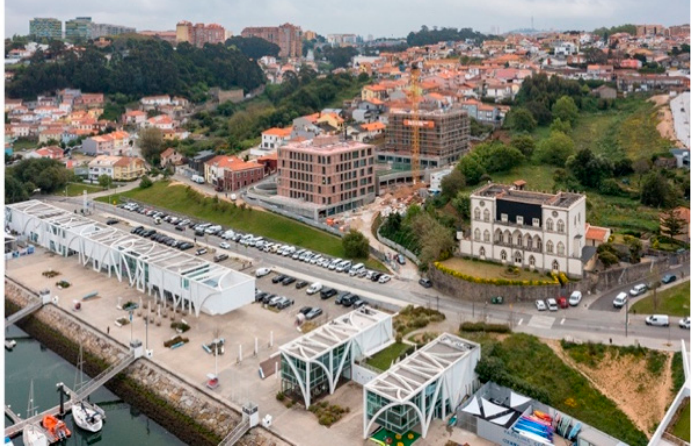
Figure 31. Vila Nova de Gaia. ©João Ferrand.